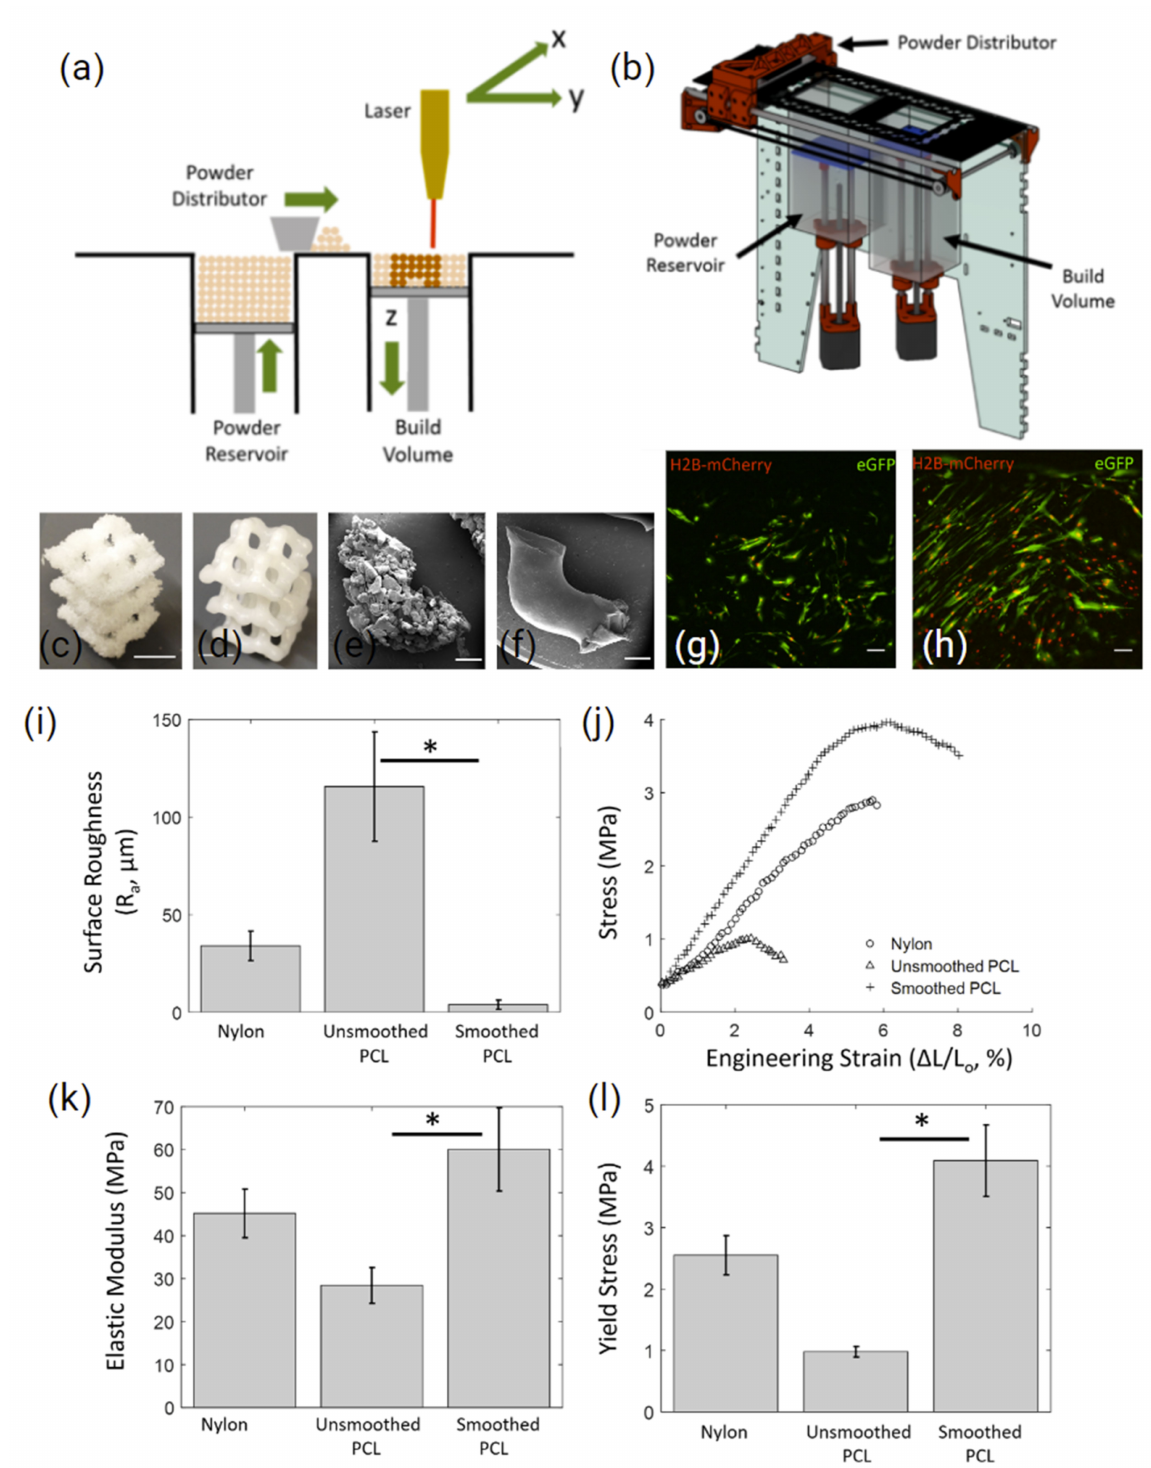
Figure 6. ( a , b ) A schematic and 3D render of the custom recoating platform developed to build up PA 12 and PCL powder in the Z direction with the use of a laser cutter. Surface finish of PCL sintered diamond lattice, before ( c,e ) and after vapour smoothing ( d , f ) (scale bars = 1 mm), ( g ) shows hMSC morphology on sintered PCL and ( h ) shows hMSC morphology on vapour-smoothed sintered PCL (scale bar = 1000 µ m). ( i – l ) Surface roughness and mechanical properties of sintered PA 12 and PCL as well as vapour-smoothed sintered PCL. * denotes p < 0.01 using Student’s t -test. Plots represent mean ± SD. Adapted from